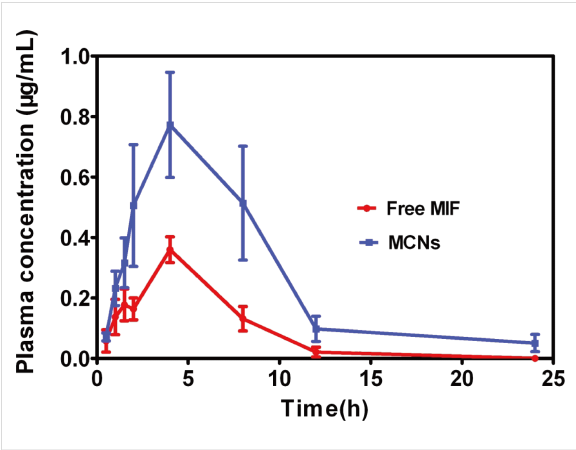
Figure 8: In vivo plasma concentration vs time of different MIF formu- lations. Male SD rats were given a single 30 mg/kg dose of MIF (in soybean oil solution) or a single dose of MCNs equivalent to the same dosage of MIF. Blood samples (each 0.5 mL) were collected into heparinized tubes from the orbital venous plexus at different time points after oral administration.